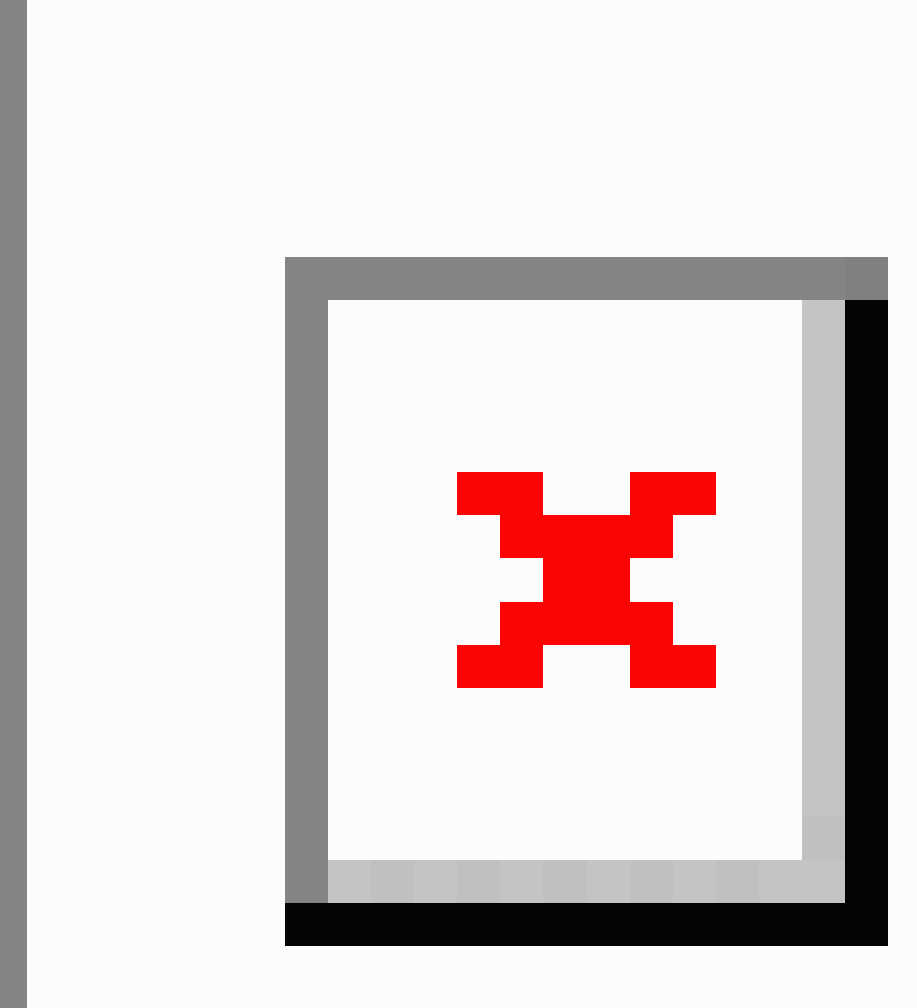
Figure 2. Experimental